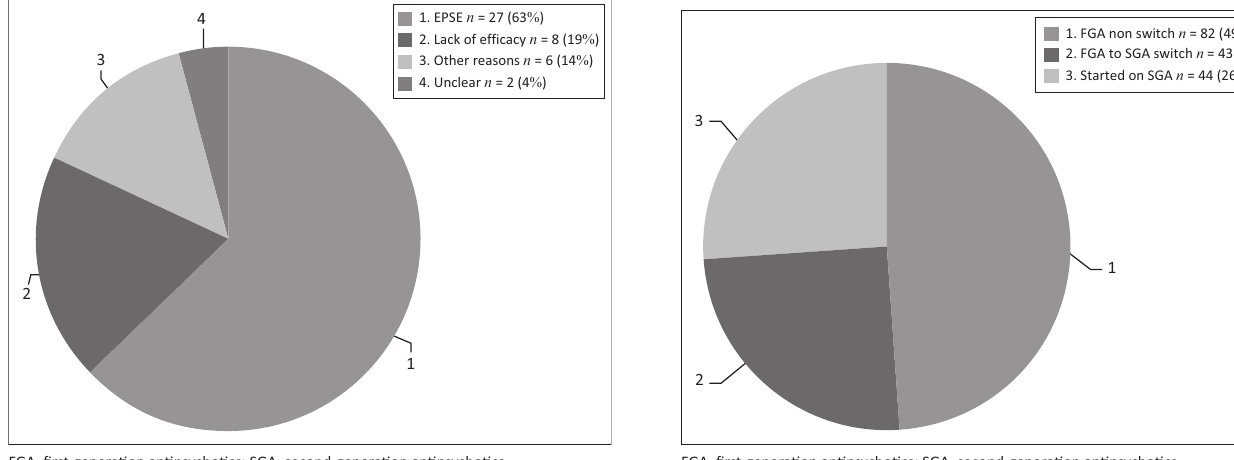
FIGURE 4: Reasons for switching from FGA to SGA. FIGURE 5: Patterns of antipsychotic use, three distinct